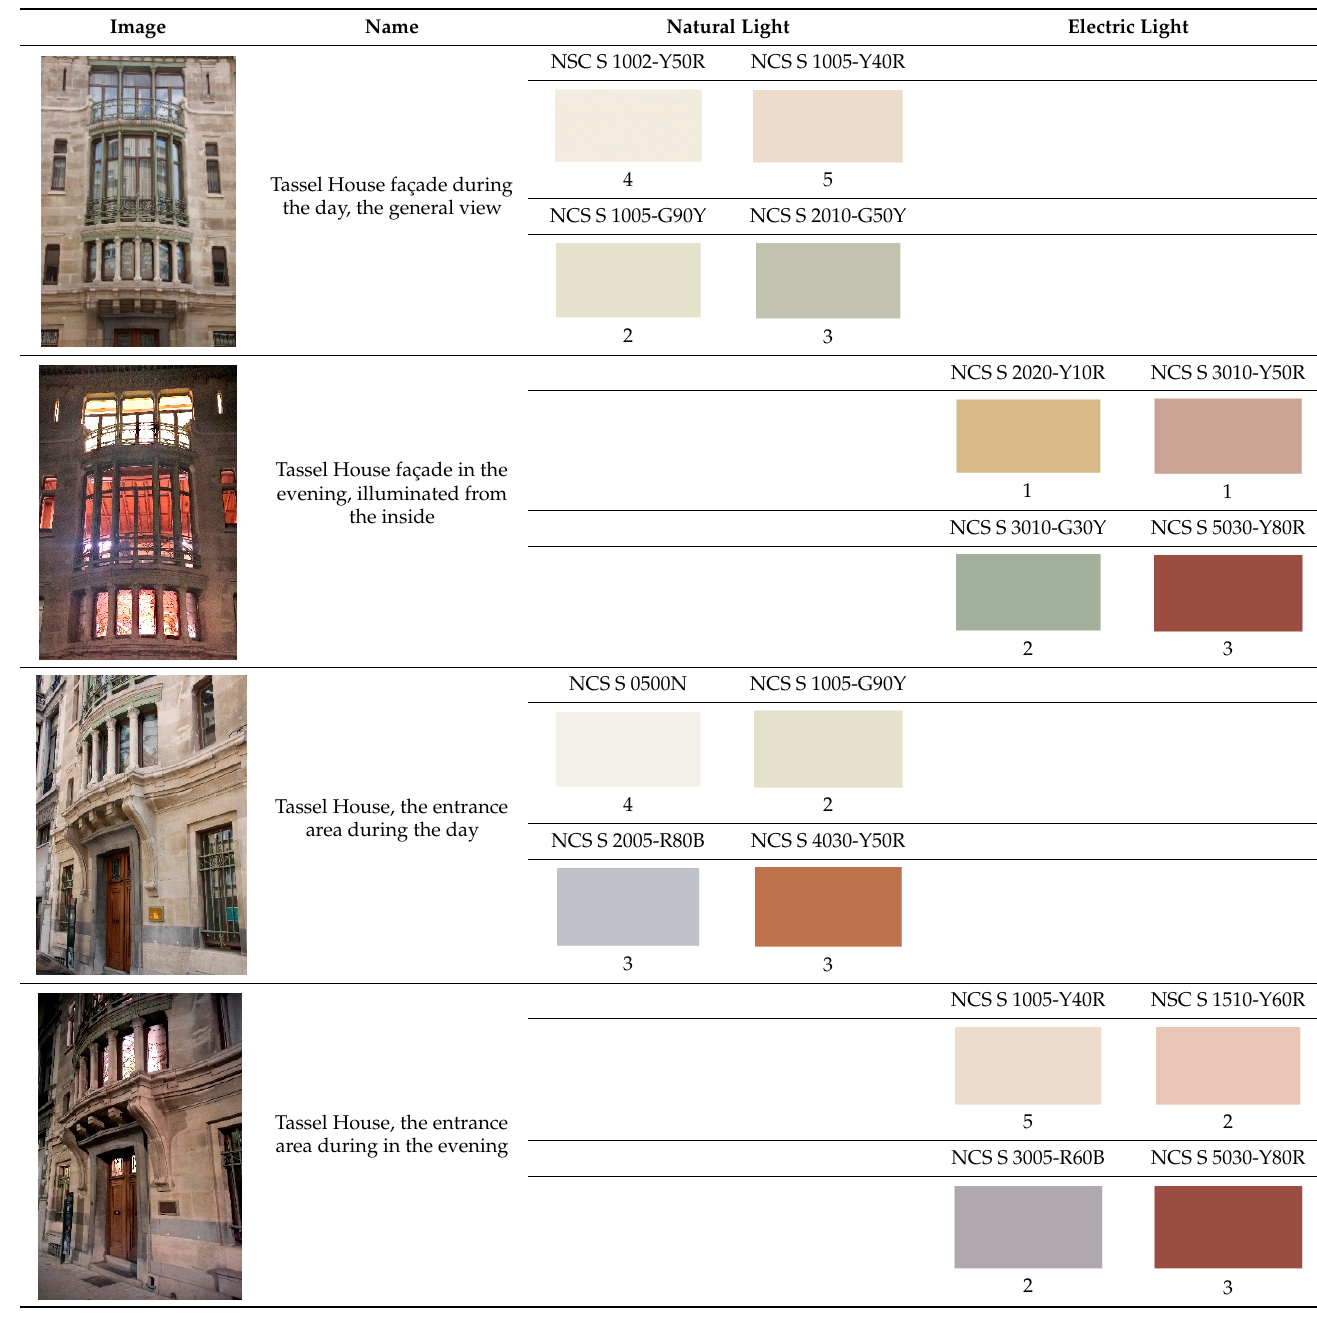
Table A4. The colors of the exterior façades of the examined buildings designed by Victor Horta.